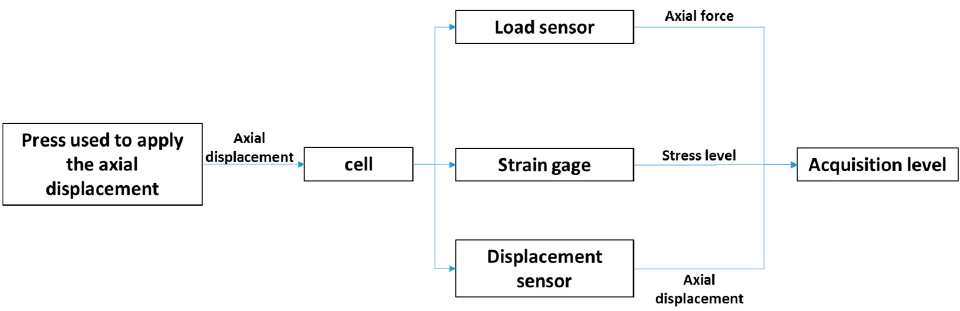
Figure 12. Prototype of a single cell.